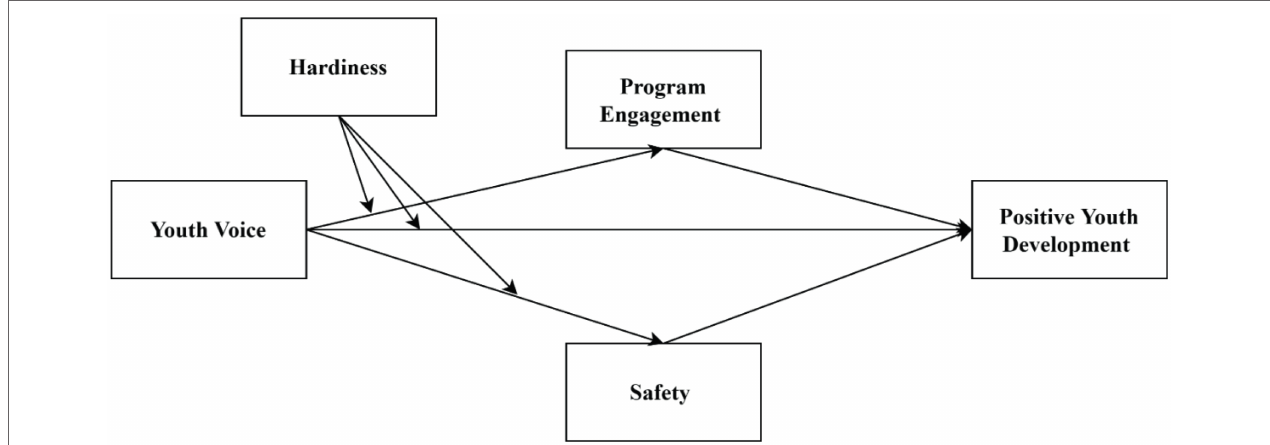
FIGURE 1 | Hypothesized path